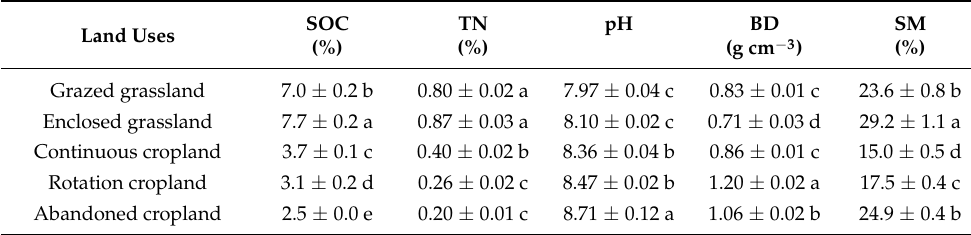
Table 3. The averaged soil characters for each sample site ( n = 4). Note that SOC and TN represent soil organic carbon and total nitrogen contents; BD means bulk density, and SM represent soil moisture. Different letters indicate the significance between land-use